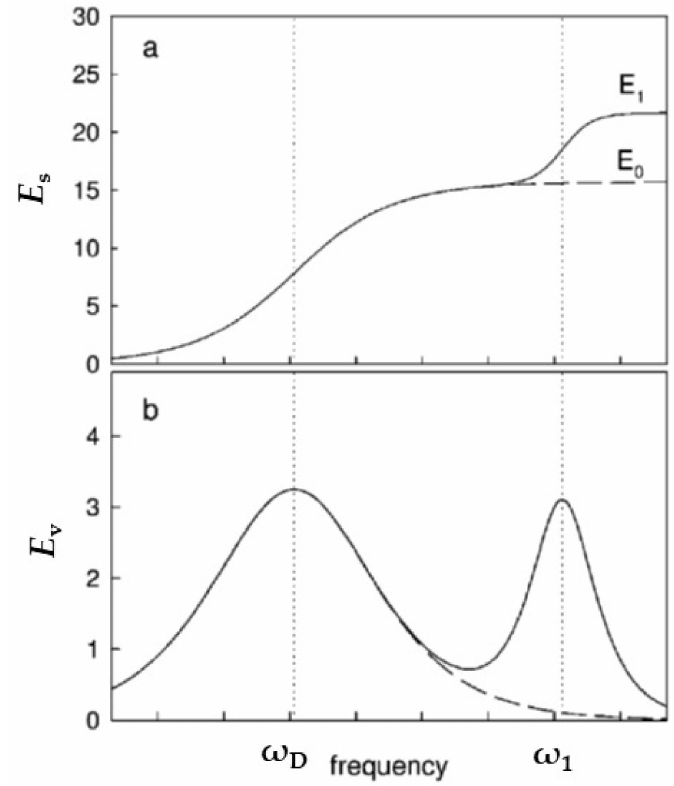
Figure 3. Sketch of the typical dependences of the ( a ) real and ( b ) imaginary parts of the viscoelastic modulus for fluid/fluid interfaces presenting different relaxation processes. The dashed lines corre- spond to a system presenting a relaxation process characterized by a relaxation process defined in terms of the Lucassen-van der Tempel model, and the continuous lines represent the typical behavior of a fluid/fluid interfaces where a relaxation process affecting only the interface is coupled to a Lucassen-van der Tempel-like relaxation. Reprinted from Liggieri et al. [104], with permission from Royal Society of Chemistry, Copyright